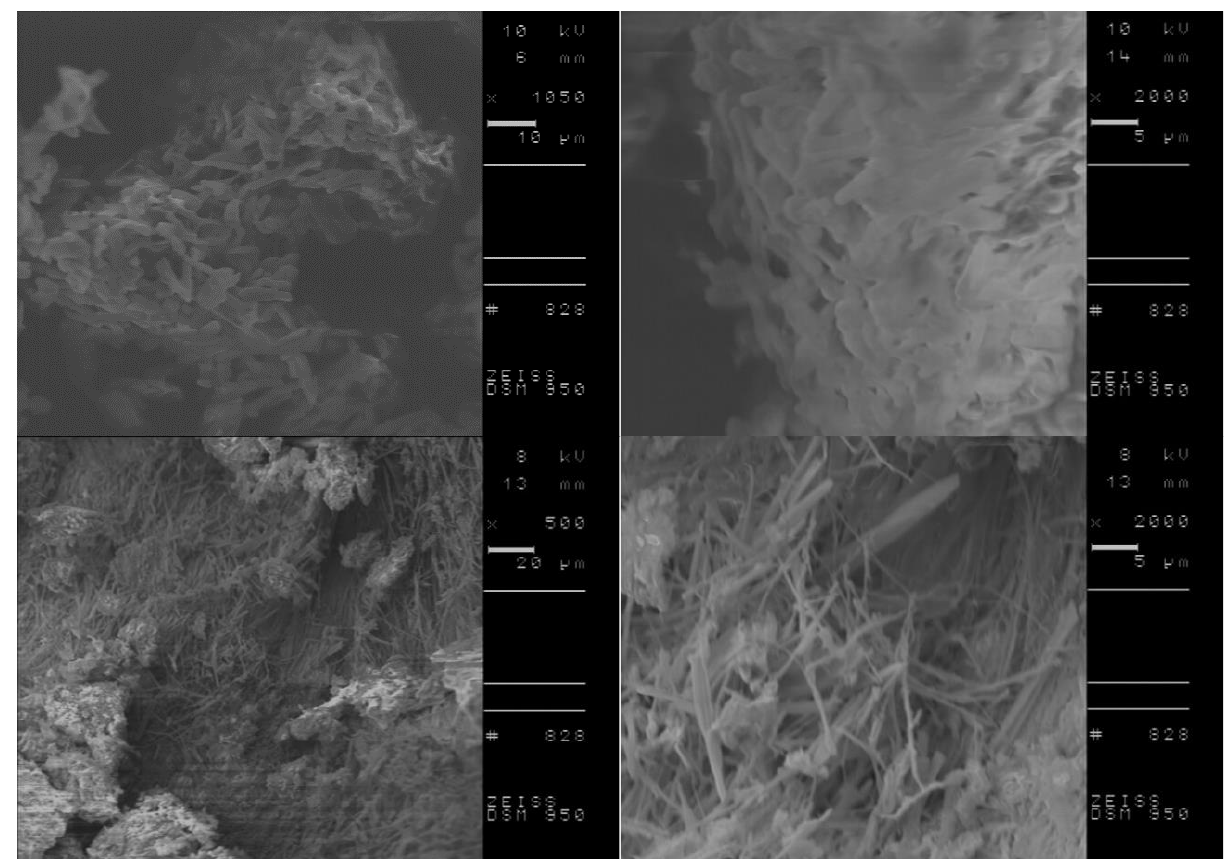
Figure 8. The SEM micrographs of [L-MetOiPr][NAP]; in the top row: before the conditioning step and in the bottom row: after the conditioning step; on the right: enlarged 2000 times SEM image; on the left side lower magnification.